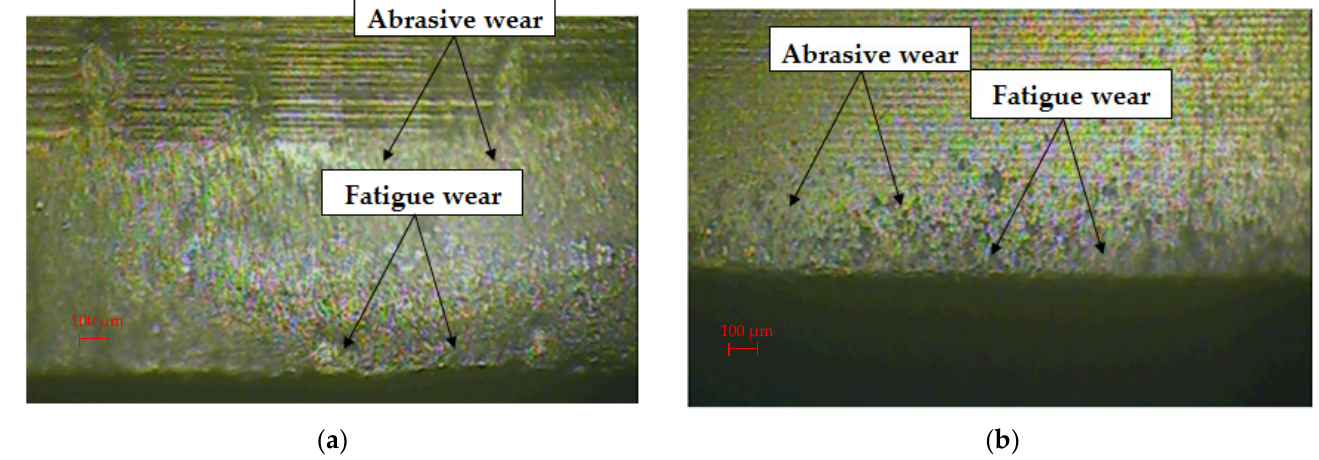
Figure 5. Edge and face wear of the punch at the 120,000 strokes: ( a ) uncoated; ( b ) coated.